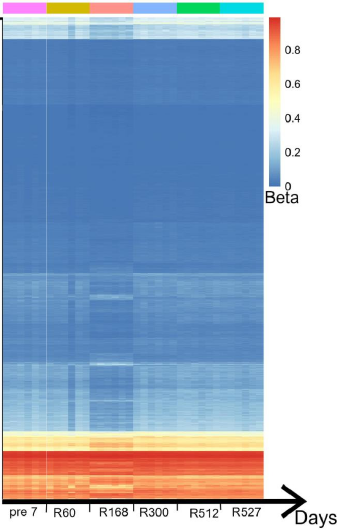
Figure 1. Heatmap of differential methylation probes in Mars 520 samples. The differential methylation analysis of Mars 520 samples resulted in 6470 DMPs. The horizontal axis shows the time change, six time points in the Mars 520 sample: Pre7: One week before the mission; R60: Day 60 of the mission; R168: Day 168 of the mission; R300: Day 300 of the mission; R512: Day 512 of the mission; R527: Day 527 of the mission. Each column is a sample, and each row is a DMP. The β values of DMPs represent the levels of methylation of probes. On day 168, the methylation levels of the gene changed significantly.